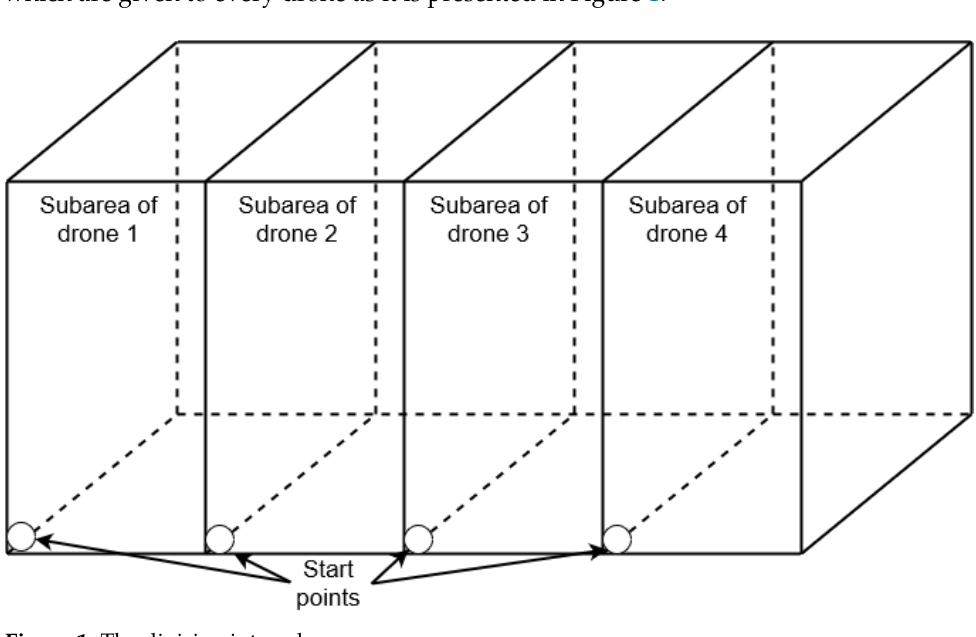
Figure 1. The division into